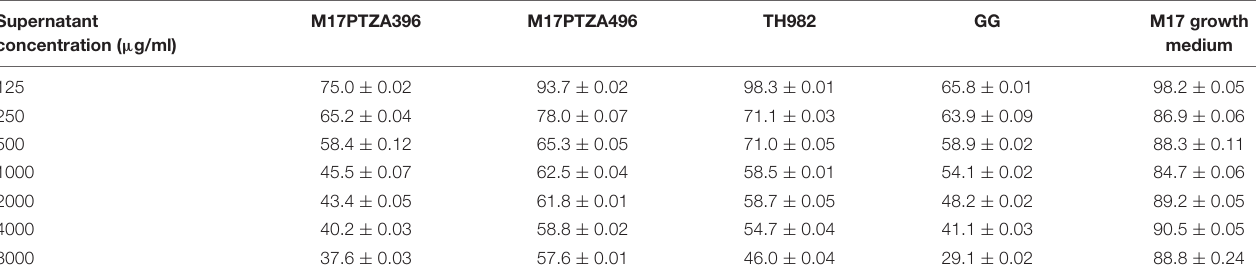
Lb. rhamnosus GG is the commercial reference probiotic strain. Growth medium M17 represents the negative control. A solution of 3% DMSO was used as positive control, which gave 26.2 ± 0.04 cell viability. Data are expressed as means ± SD.